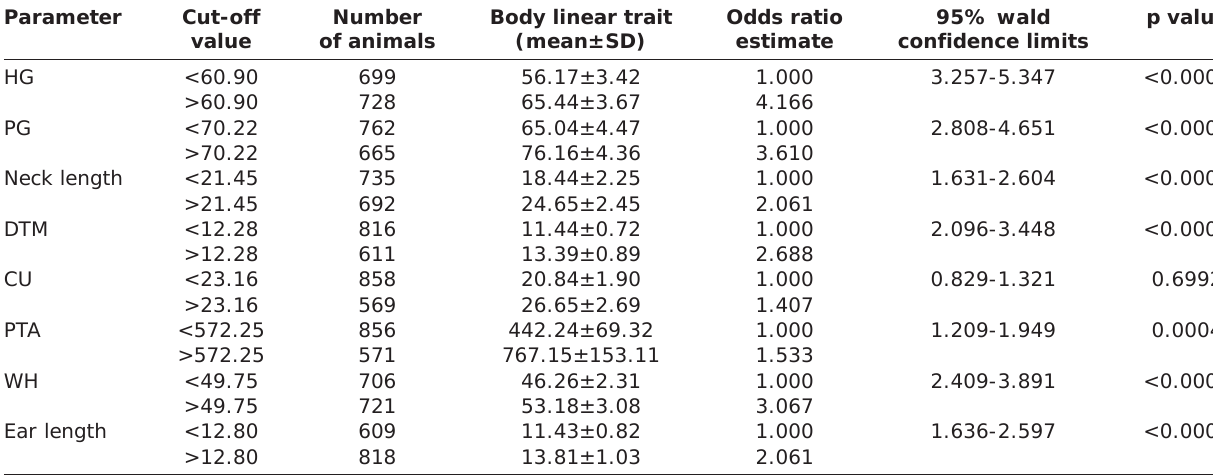
Table-5: Summary of logistic regression model of the influence of various body linear traits associated with LZs (single vs. multiple) in Indian Black Bengal goats. Parameter Cut-off value